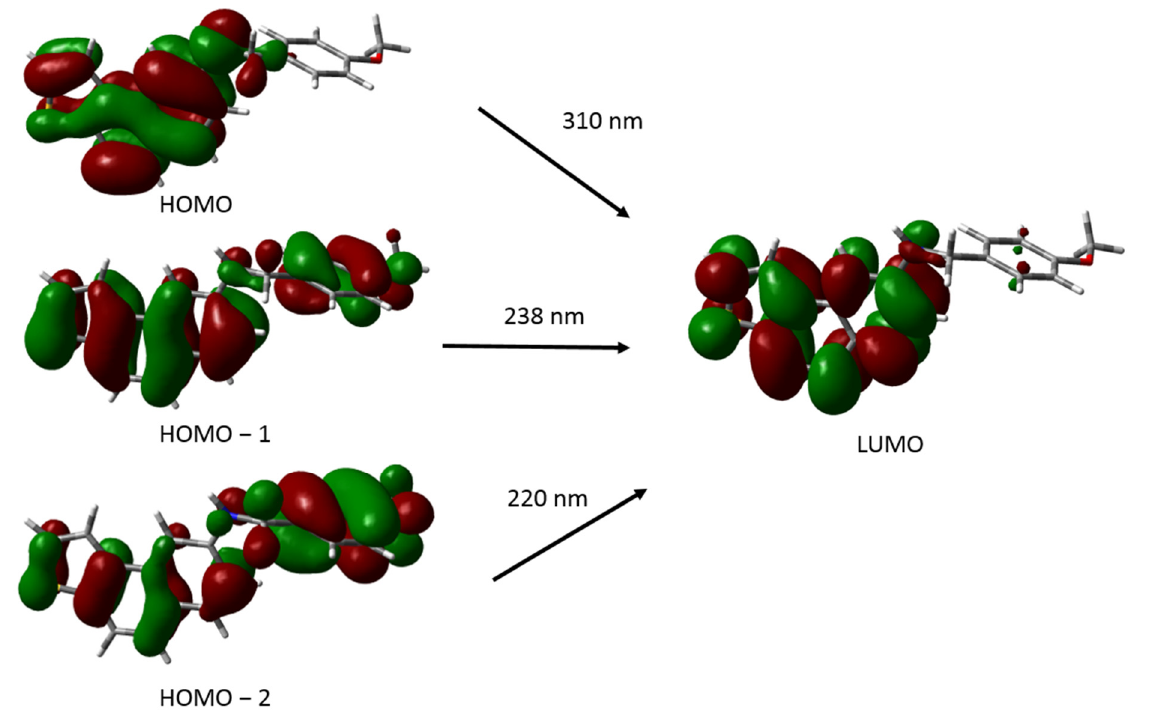
Figure 11. Canonical molecular orbitals involved in transitions in UV-Vis spectra of compound 13 .